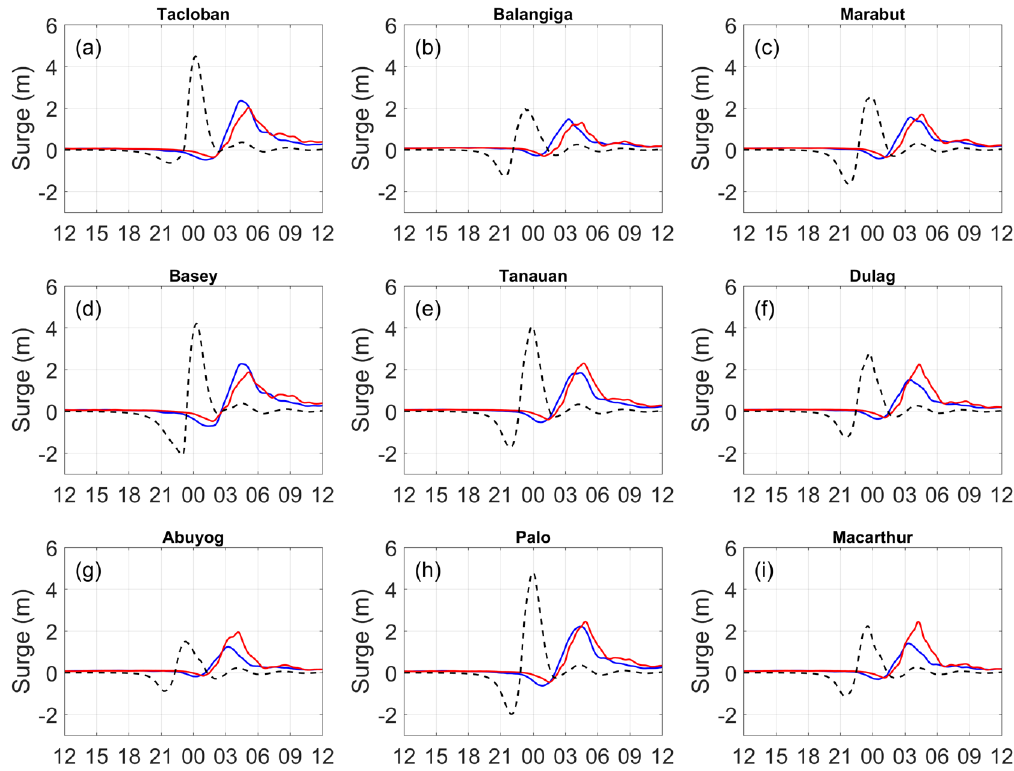
Figure 16. ( a – i ) Time series of the computed storm surges driven by WRF-ARW 3 km ( blue lines ), WRF-ARW 1 km ( red lines ) and HWM ( dashed black lines ) in the numerical gauges. The detailed information of numerical gauges can be found in Figure 2b and Table 2. The x -axis indicates the time from 12:00 UTC 7 November 2013 to 12:00 UTC 8 November 2013.